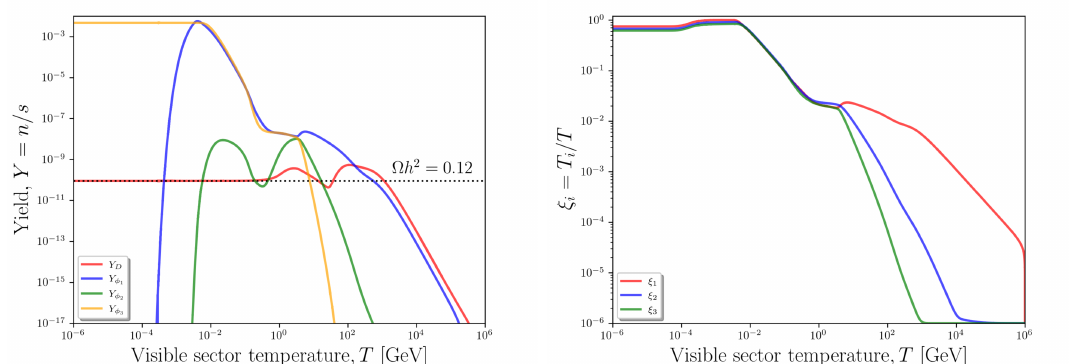
Figure 6. The case of three initially cold dark sectors. Left panel: evolution of the yields of the dark fermion D and the scalars of the dark sector versus the visible sector temperature. Right panel: evolution of the temperature ratios ξ i . The input parameters are: m D = 5 . 0 GeV, m φ m φ = 105 MeV, m φ = 0 , y f = 6 . 7 × 10 − 10 , y D = 0 . 17 and κ 1 = κ 2 = 10 − 7 . Total relic density is 2 3 Ω h 2 = Ω h 2 = 0 . 123 . As discussed in subsection 5.2, this case leads to extra relativisitc degrees of D freedom at BBN time so that ∆ N BBN = 0 . 323 eff